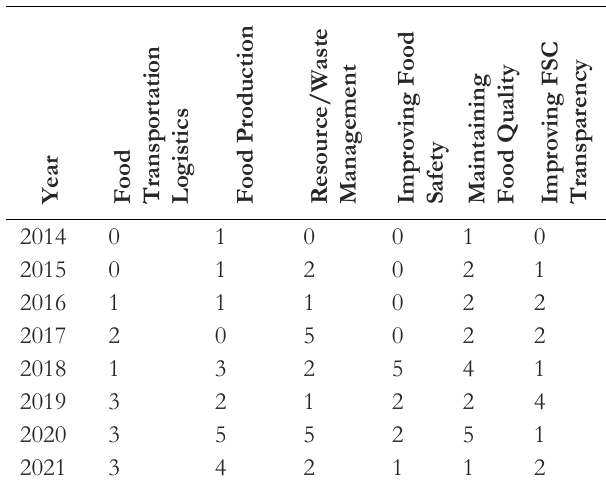
Table 3. Number of the journal, conference, and published articles related to IoT